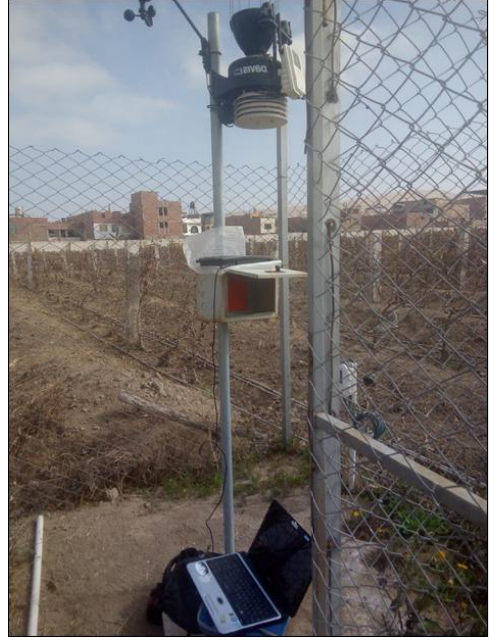
Figure 1. Weather station Davis Instruments, Vantage Pro2 Plus .